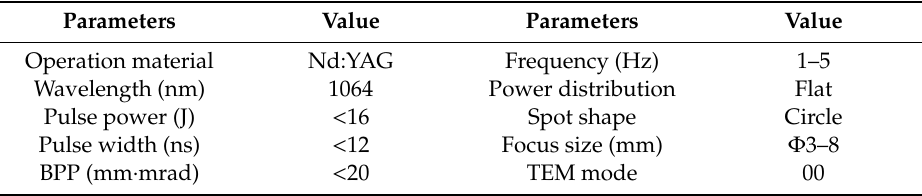
Table 2. Technical parameters of Nd:YAG laser.